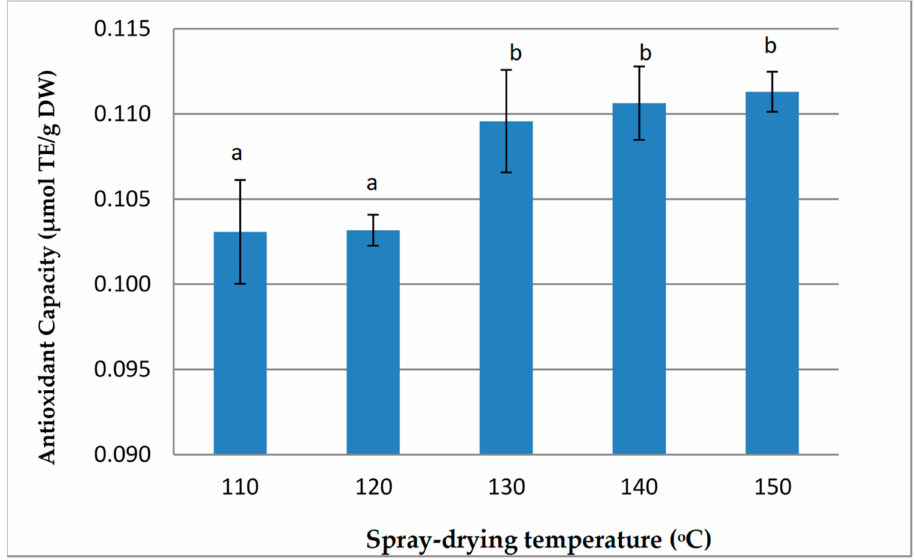
Figure 6. Antioxidant capacity of lemongrass leaf extract powders at different spray-drying temperatures. All data are the mean ± SD. Values with different letters are significantly different ( p <